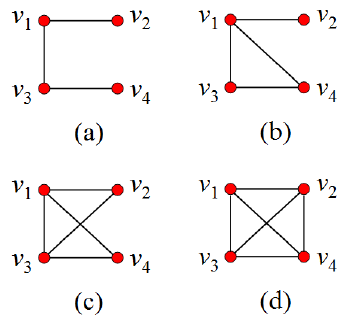
Figure 1. Four situations of two independent edges